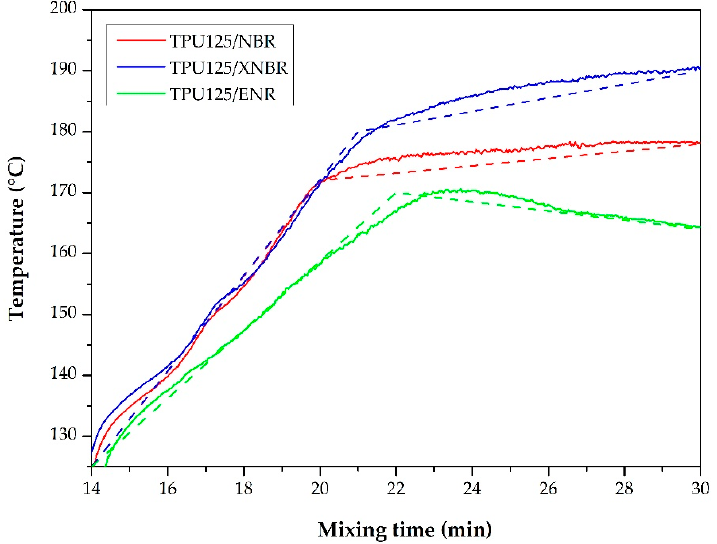
Figure 5. The real temperature profiles recorded during the production of TDVs (——) and their approximate curves (– – –) that were used for the non-isothermal curing test for the rubber compounds.